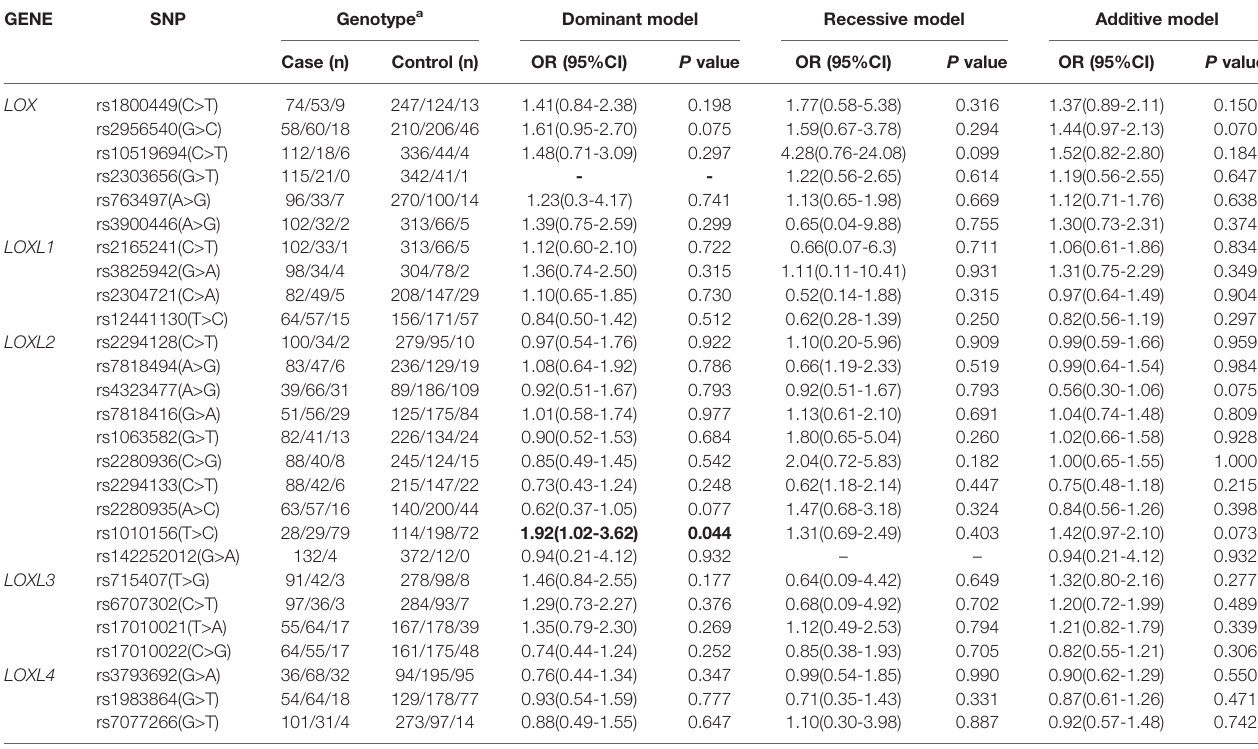
TABLE 5 | Univariate logistic regression analysis of association of polymorphisms in LOX family genes and risk of multiple IAs in a Chinese population. GENE SNP Genotype a Dominant model Recessive model Additive